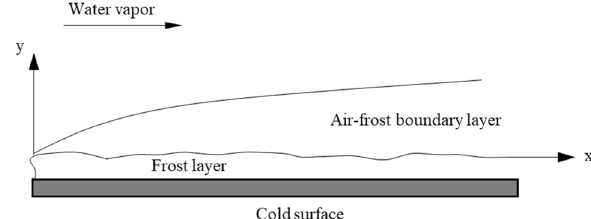
Figure 1. Physical model of frost growth on cold plate.